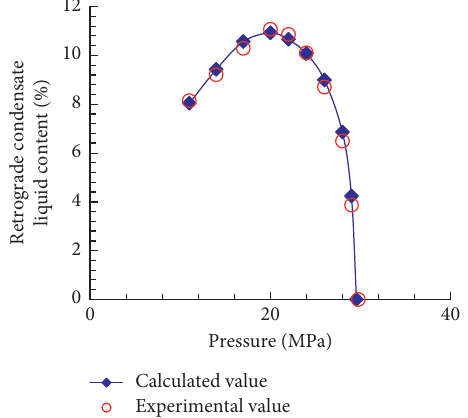
Figure 9: Comparison for sample 2 of calculated and experimental relationship diagram between retrograde condensate liquid volume and